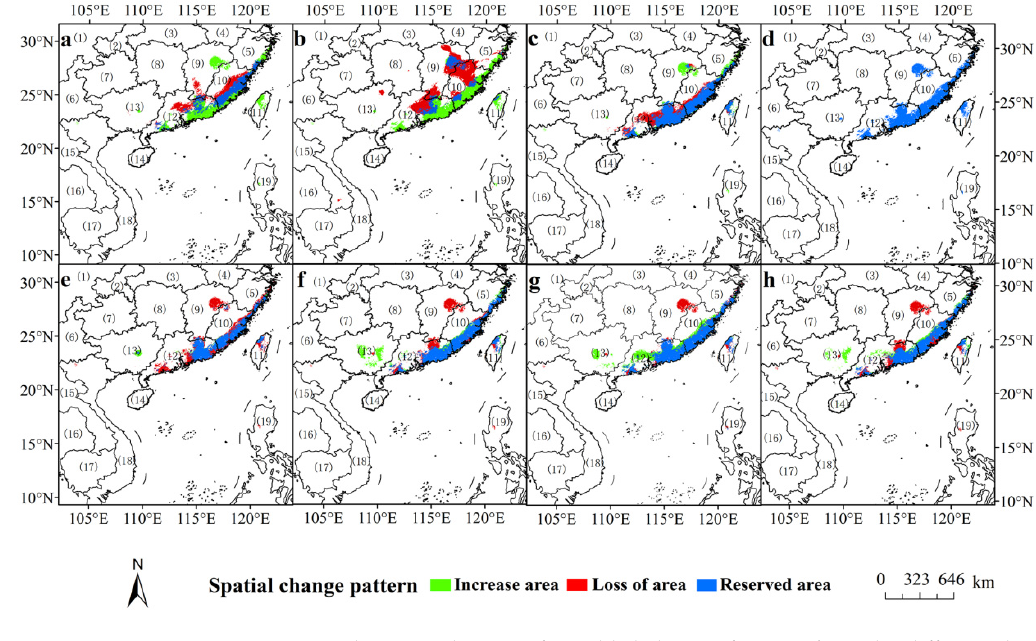
Figure 5. Spatial pattern changes of suitable habitats of G. pensilis under different climate change scenarios. ( a ) last interglacial (LIG), ( b ) last glacial maximum (LGM), ( c ) middle Holocene (MH), ( d ) current and ( e ) Representative concentration pathway (RCP) 2.6-2050s, ( f ) RCP8.5-2050s, ( g ) RCP2.6-2070s and ( h ) RCP8.5-2070s. (1) Sichuan; (2) Chongqing; (3) Hubei; (4) Anhui; (5) Zhejiang; (6) Yunnan; (7) Guizhou; (8) Hunan; (9) Jiangxi; (10) Fujian; (11) Taiwan; (12) Guangdong; (13) Guangxi; (14) Hainan; (15) Laos; (16) Thailand; (17) Cambodia; (18) Vietnam; (19) Philippines. Consecutive numbers (1)–(14) are the provinces of China.